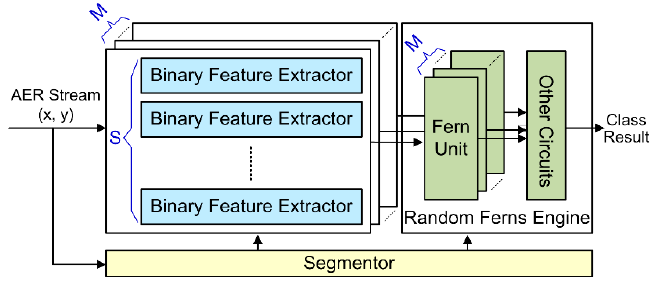
Figure 1. Hardware architecture of the proposed VLSI system .